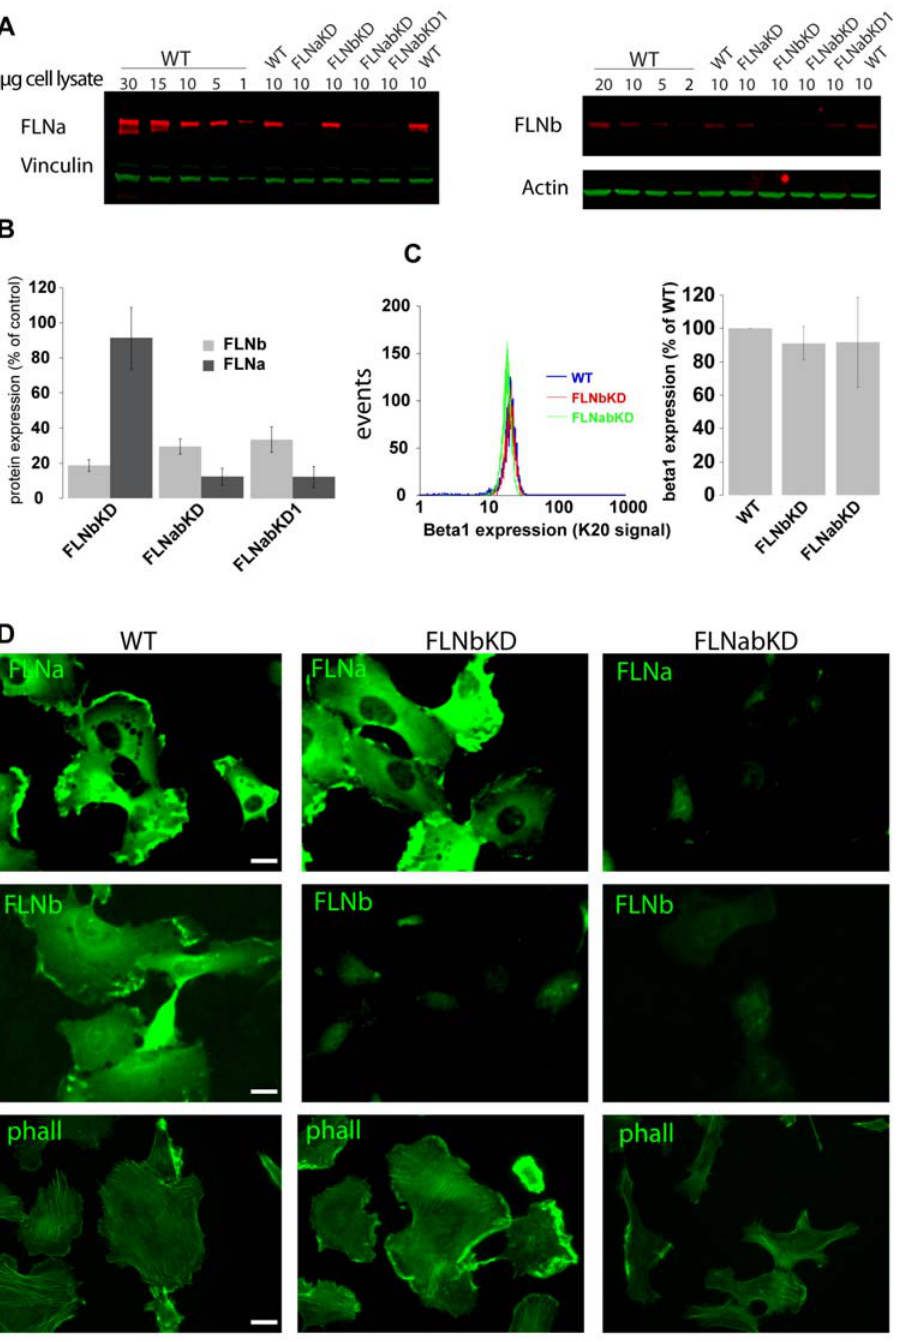
Figure 3. Generation of FLNabKD cells. A ) FLNa and FLNb protein expression was quantified comparing 10 m g of cell lysate prepared from FLNaKD, FLNbKD and FLNabKD cells to a curve of cell lysates prepared from HT1080 WT lysates. Vinculin and actin were used as loading control. B ) Quantification of FLNa and FLNb protein expression; bars show mean value normalized to control 6 SEM (n=4). C ) Integrin beta1 present on the membrane surface of WT, FLNbKD and FLNabKD cells. The left panel shows a representative histogram plot, the right panel shows the average of 4 experiments 6 standard deviation. D ) HT1080WT, FLNbKD or FLNabKD cells were plated on FN-coated coverslips, incubated overnight, fixed, permeabilized and stained with anti-FLNa (FLNa), anti-FLNb (FLNb) or phalloidin (phall). Bar=20 m